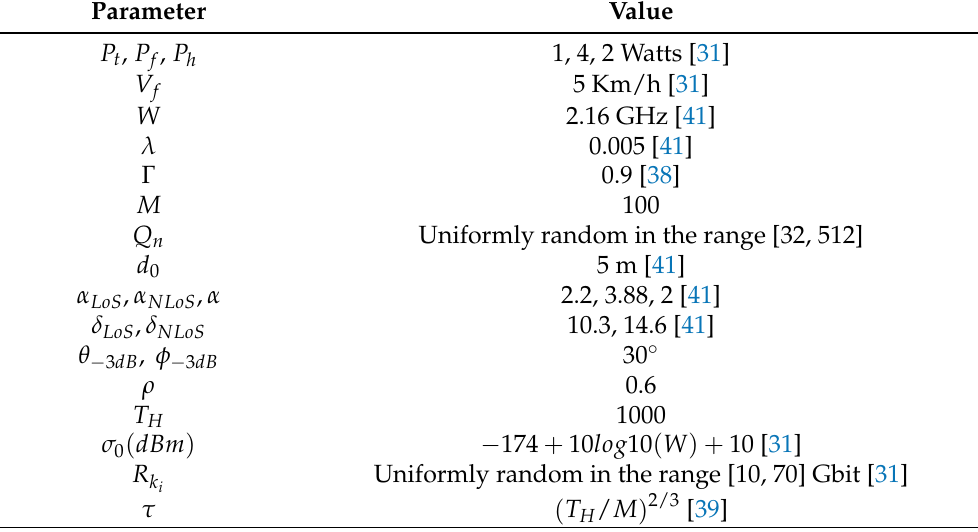
Table 2. Simulation